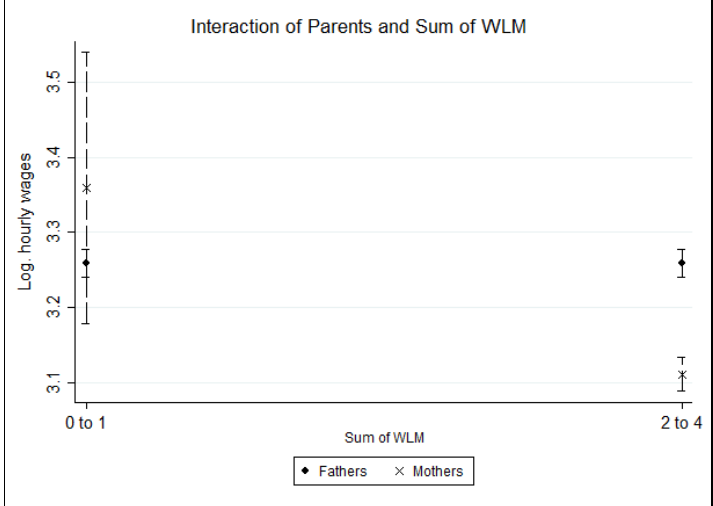
Figure A2. Log. hourly wages of fathers and mothers by the amount of WLM combined with EQM (predictive margins of parents with 95% CIs using Stata 14; based on Table 5).